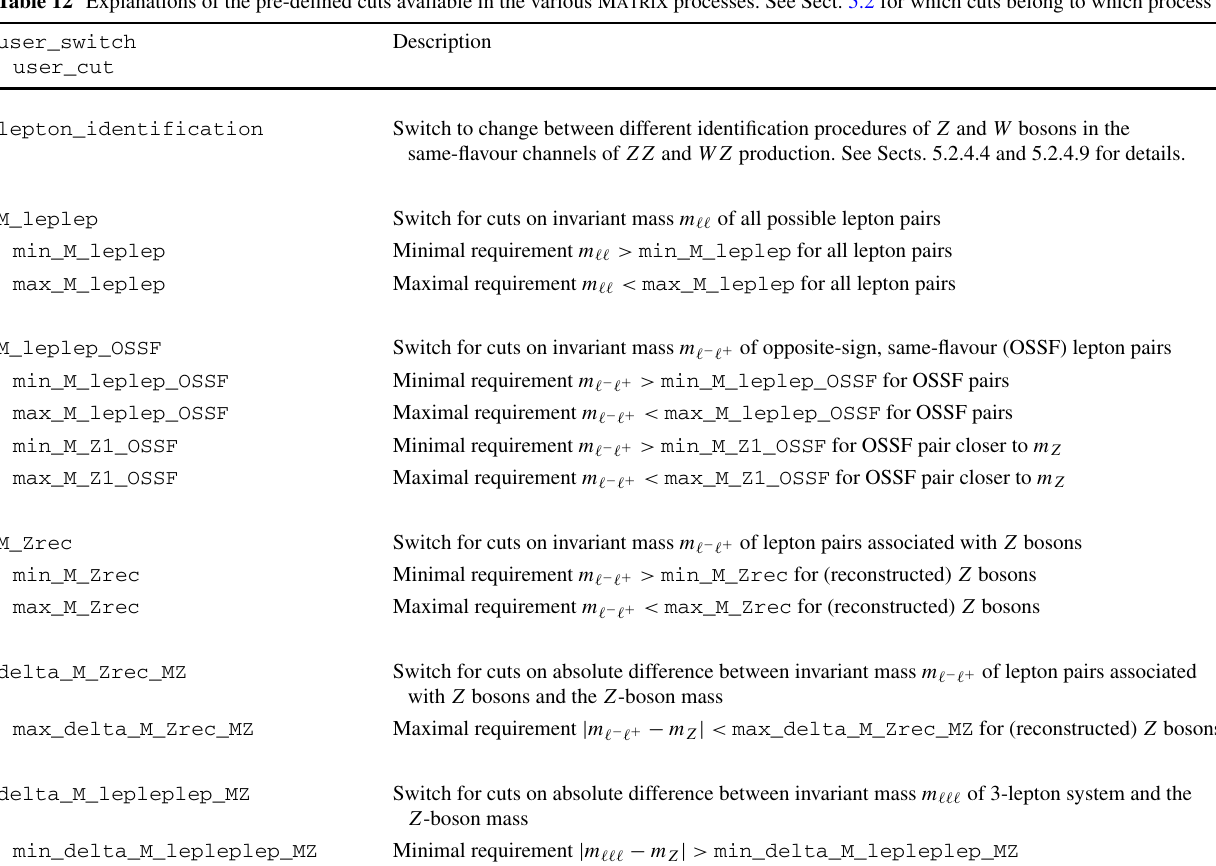
Table 12 Explanations of the pre-defined cuts available in the various Matrix processes. See Sect. 5.2 for which cuts belong to which process user_switch Description